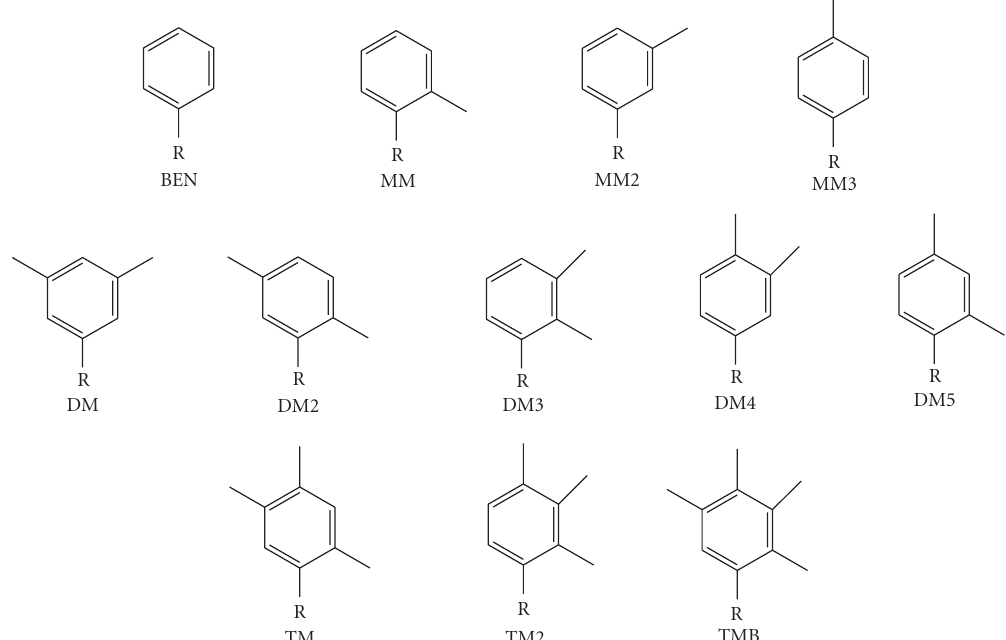
Figure 3: Small molecule analogs based on the benzene parent. BEN is benzene; the MM series is monomethylated at the 2, 3, and 4 positions, respectively; the DM series is dimethylated; the TM series is trimethylated; TMB is the tetramethylated benzene analog